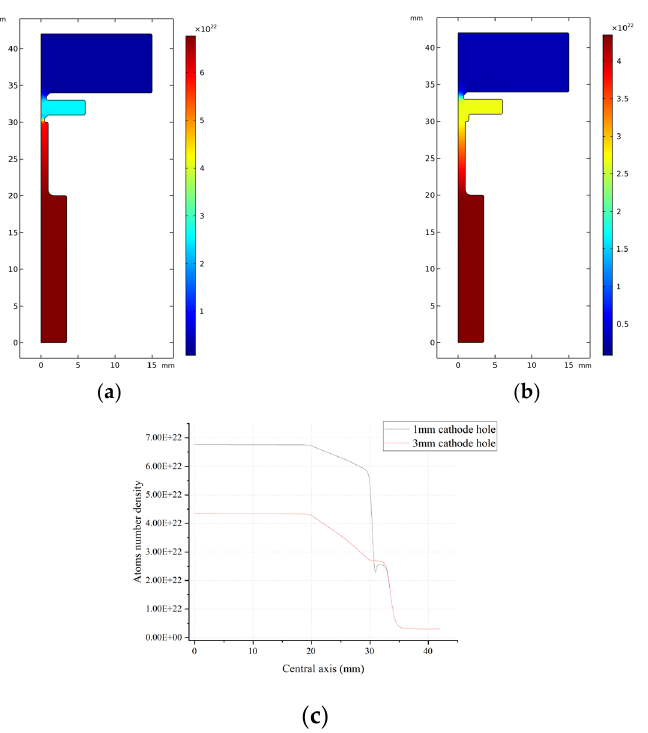
Figure 9. ( a ) Contours of atom number density distribution of C12A7 hollow cathode with cathode orifice 1 mm. ( b ) Contours of atom number density distribution of C12A7 hollow cathode with cath- ode orifice 3 mm. ( c ) Atom density variation on the symmetry axis along the Z-direction. As can be seen from the electron number density simulation distribution cloud, Fig-